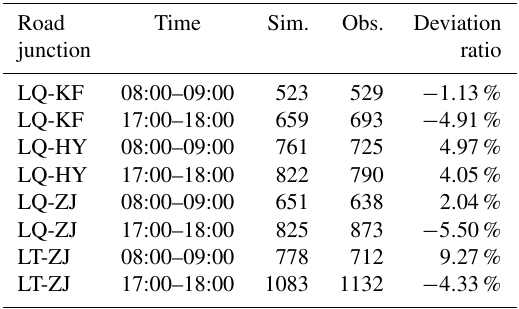
Table 7. Traffic flow and population simulation results during peak hours on